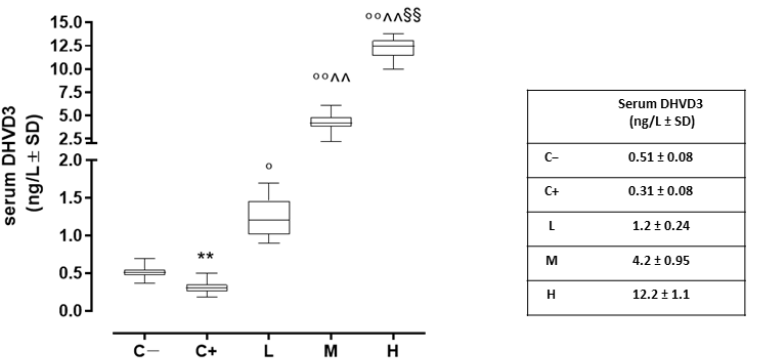
Figure 1. Serum DHVD3 levels (ng/L) in the TSP-1 KO mice euthanized at 6 weeks of age as a negative control for SS-associated dry eye (C; TSP-1 KO mice euthanized at 12 weeks of age as a positive control for SS-associated dry eye (C+); and TSP-1 KO mice supplied with a low (L), medium (M), and high (H) dose of vitamin D3 (1000, 8000, and 20,000 IU/kg/week, respectively) from week 6 to week 12 of age. N = 6 mice per group. ** p < 0.01 vs. C − ; ◦ p < 0.05 and ◦◦ p < 0.01 vs. C+; ˆˆ p < 0.01 vs. L; §§ p < 0.01 vs. M.